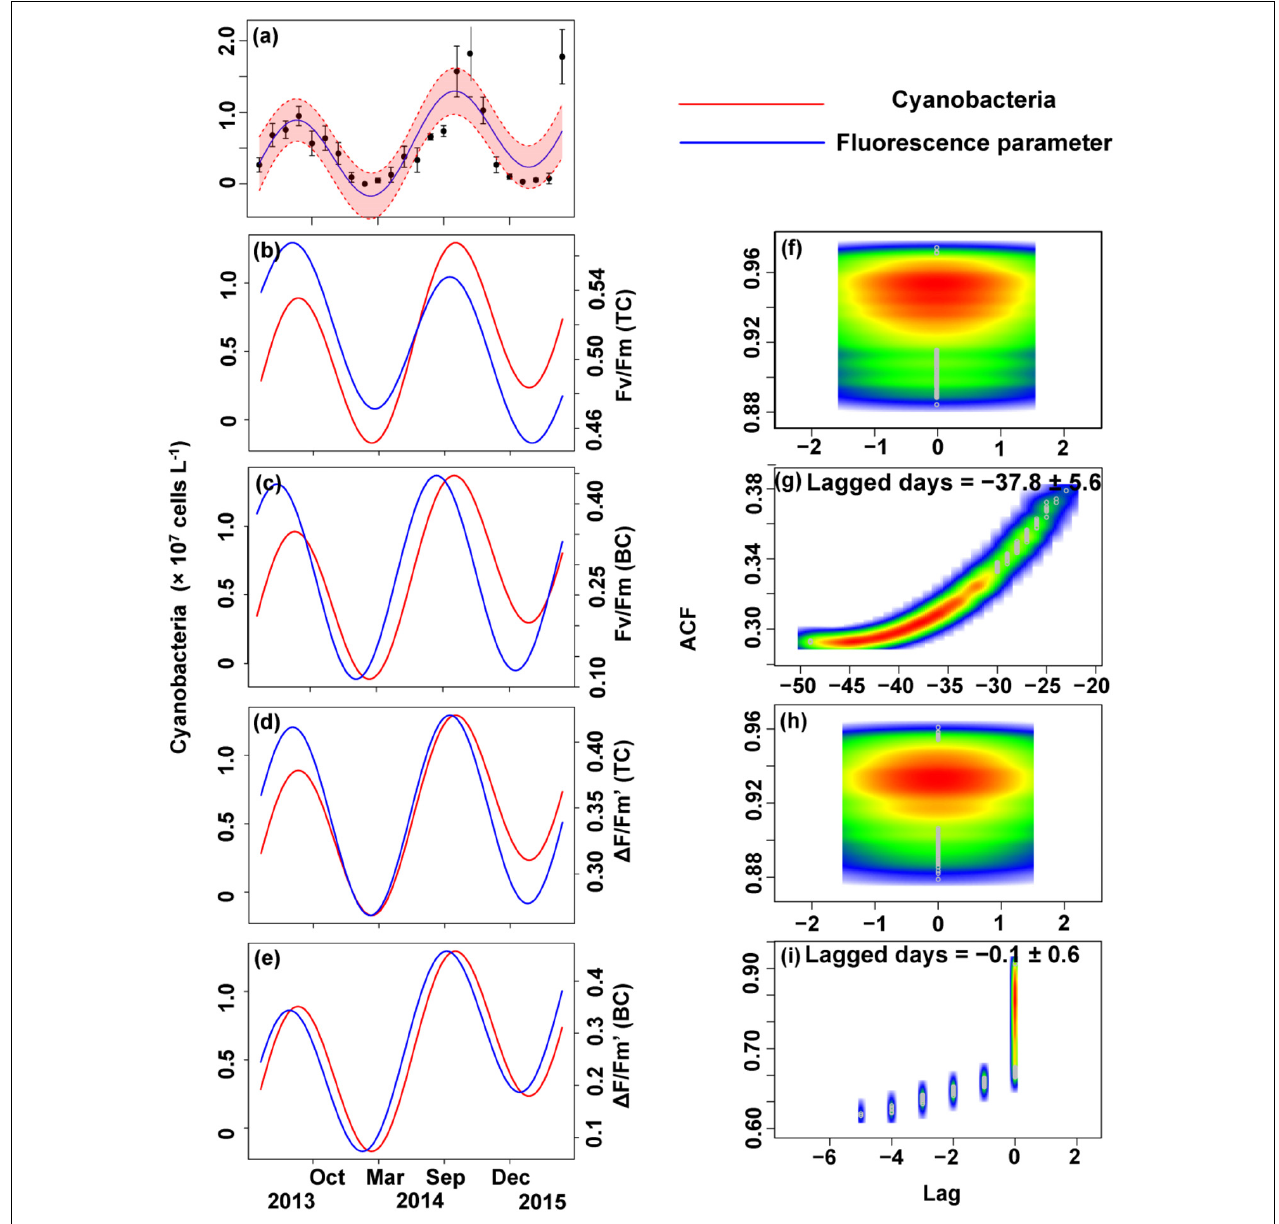
FIGURE 7 | Trigonometric regression of the cyanobacteria cell density (a) and fluorescence measurements [ F v / F m (TC) (b) , F v / F m (BC) (c) , (cid:49) F / F m (cid:48) (TC) (d) , and (cid:49) F / F m (cid:48) (BC) (e) ]. We fitted these seasonal trends with a time-lag analysis [ F v / F m (TC) (f) , F v / F m (BC) (g) , (cid:49) F / F m (cid:48) (TC) (h) , and (cid:49) F / F m (cid:48) (BC) (i) ]. The legged days and associated standard deviation among sites is shown in each